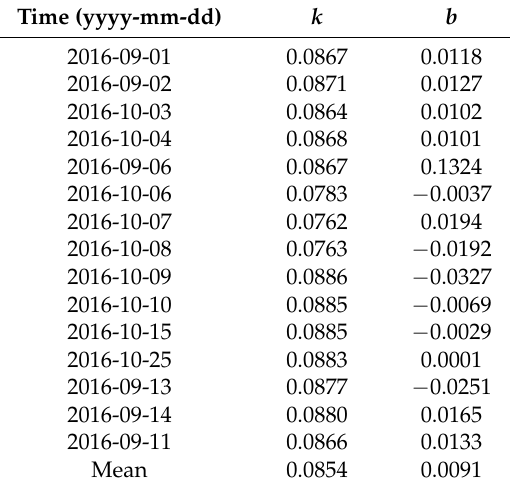
Table 3. Parameters of charging time model.